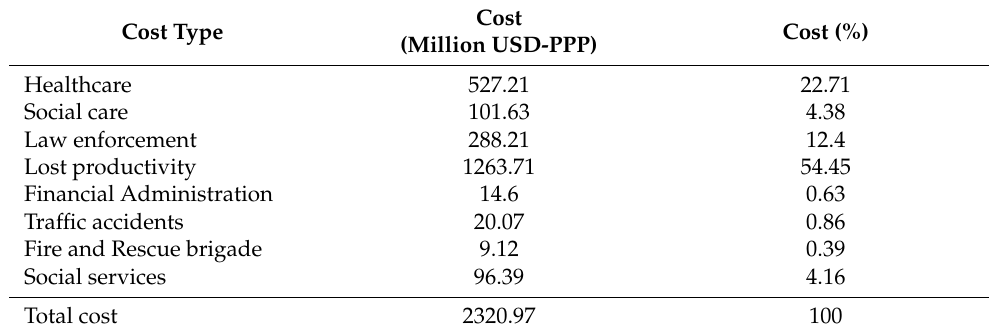
Table 15. Total cost related to